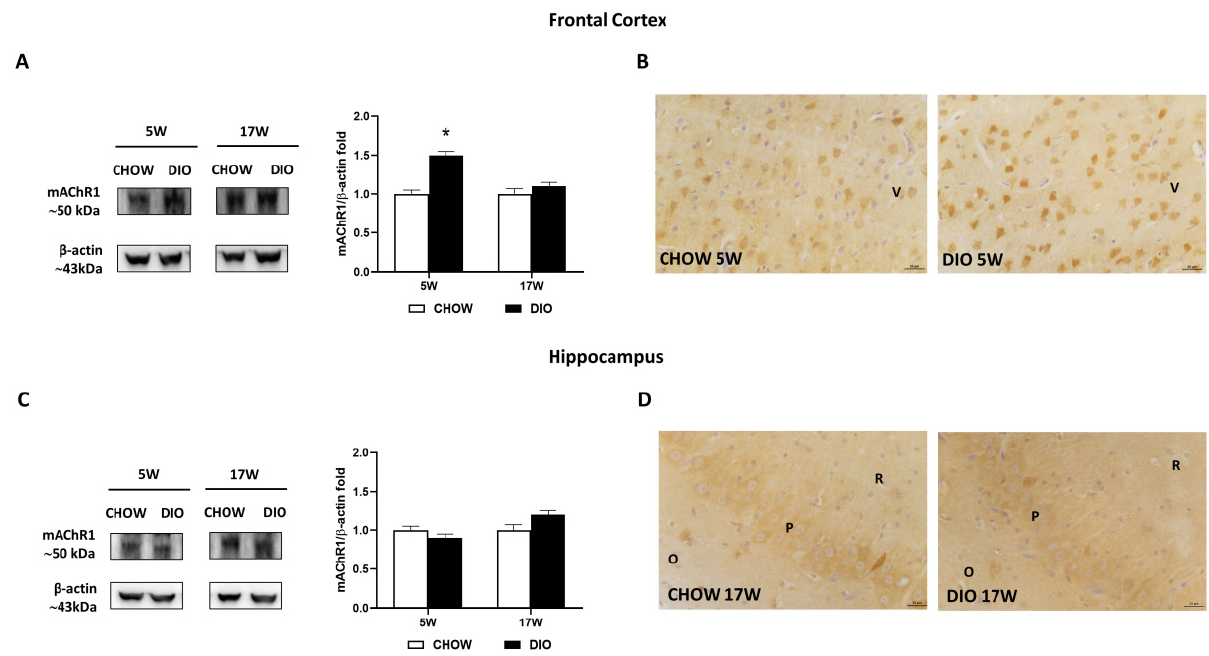
Figure 5. Western blot and immunohistochemistry of muscarinic acetylcholine receptor subtype 1 (mAChR1). Samples of frontal cortex ( A ) and hippocampus ( C ) from rats fed with standard diet (CHOW rats) and high-fat diet (DIO rats) for 5 and 17 weeks were immunoblotted with anti- mAChR1. Graphs report the densitometric data with CHOW rats as control, and β -actin was used as a reference loading protein. Data are mean ± S.E.M. * p < 0.05 vs. age-matched CHOW rats. CHOW rats 5 weeks n = 8; DIO rats 5 weeks n = 8; CHOW rats 17 weeks n = 8; DIO rats 17 weeks n = 9. Representative pictures of CHOW and DIO rats frontal cortex after 5 weeks ( B ) and hippocampus, CA3 subfield, after 17 weeks ( D ) of diet. V, fifth layer of frontal cortex; O, stratum oriens ; P, pyramidal neurons; R, stratum radiatum . Scale bar: 25 µ